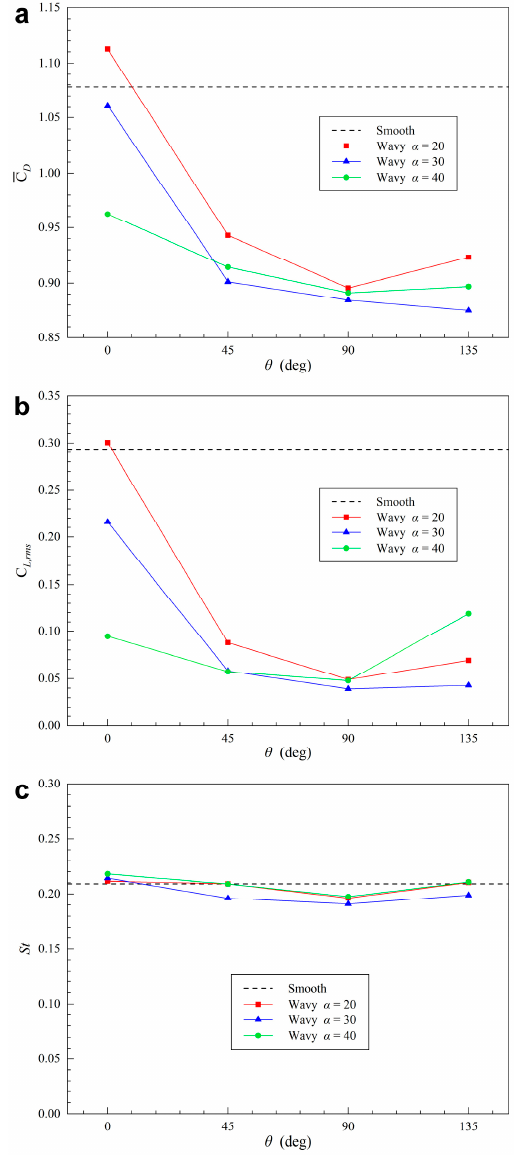
Figure 5. Comparison of ( a ) average drag coe ffi cients, ( b ) r.m.s. values of lift fluctuation, and ( c ) Strouhal numbers of three wavy cylinders and the smooth